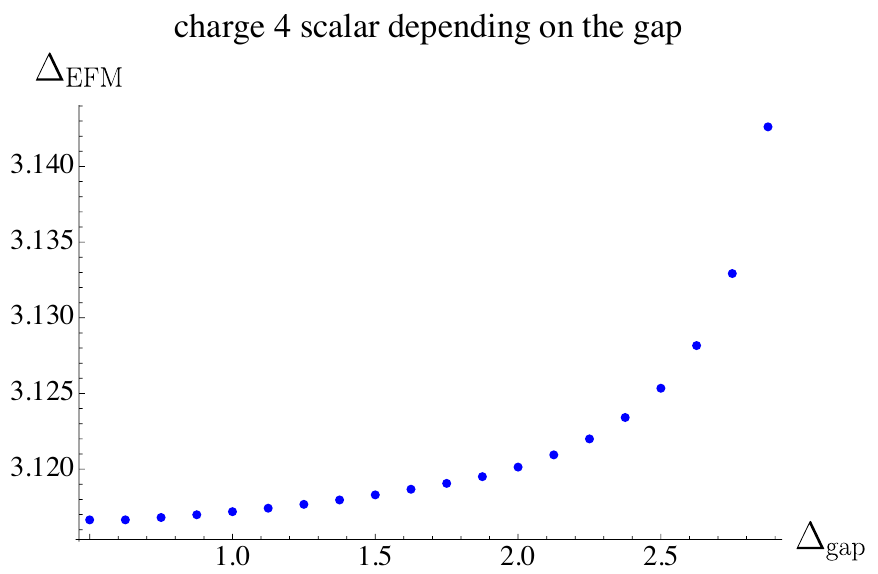
Figure 2 . Dimension of the leading charge 4 scalar operator (above the gap) as one changes the imposed gap in the charge 4 sector. Here we have chosen a single primal point and computed the extremal spectra by optimizing the upper bound on the OPE coe(cid:14)cient f (cid:30)(cid:30)s . This plot gives a clear illustration of the sharing e(cid:11)ect, where when we impose gaps closer to the target operators, we get less accurate results from the extremal functional method in some